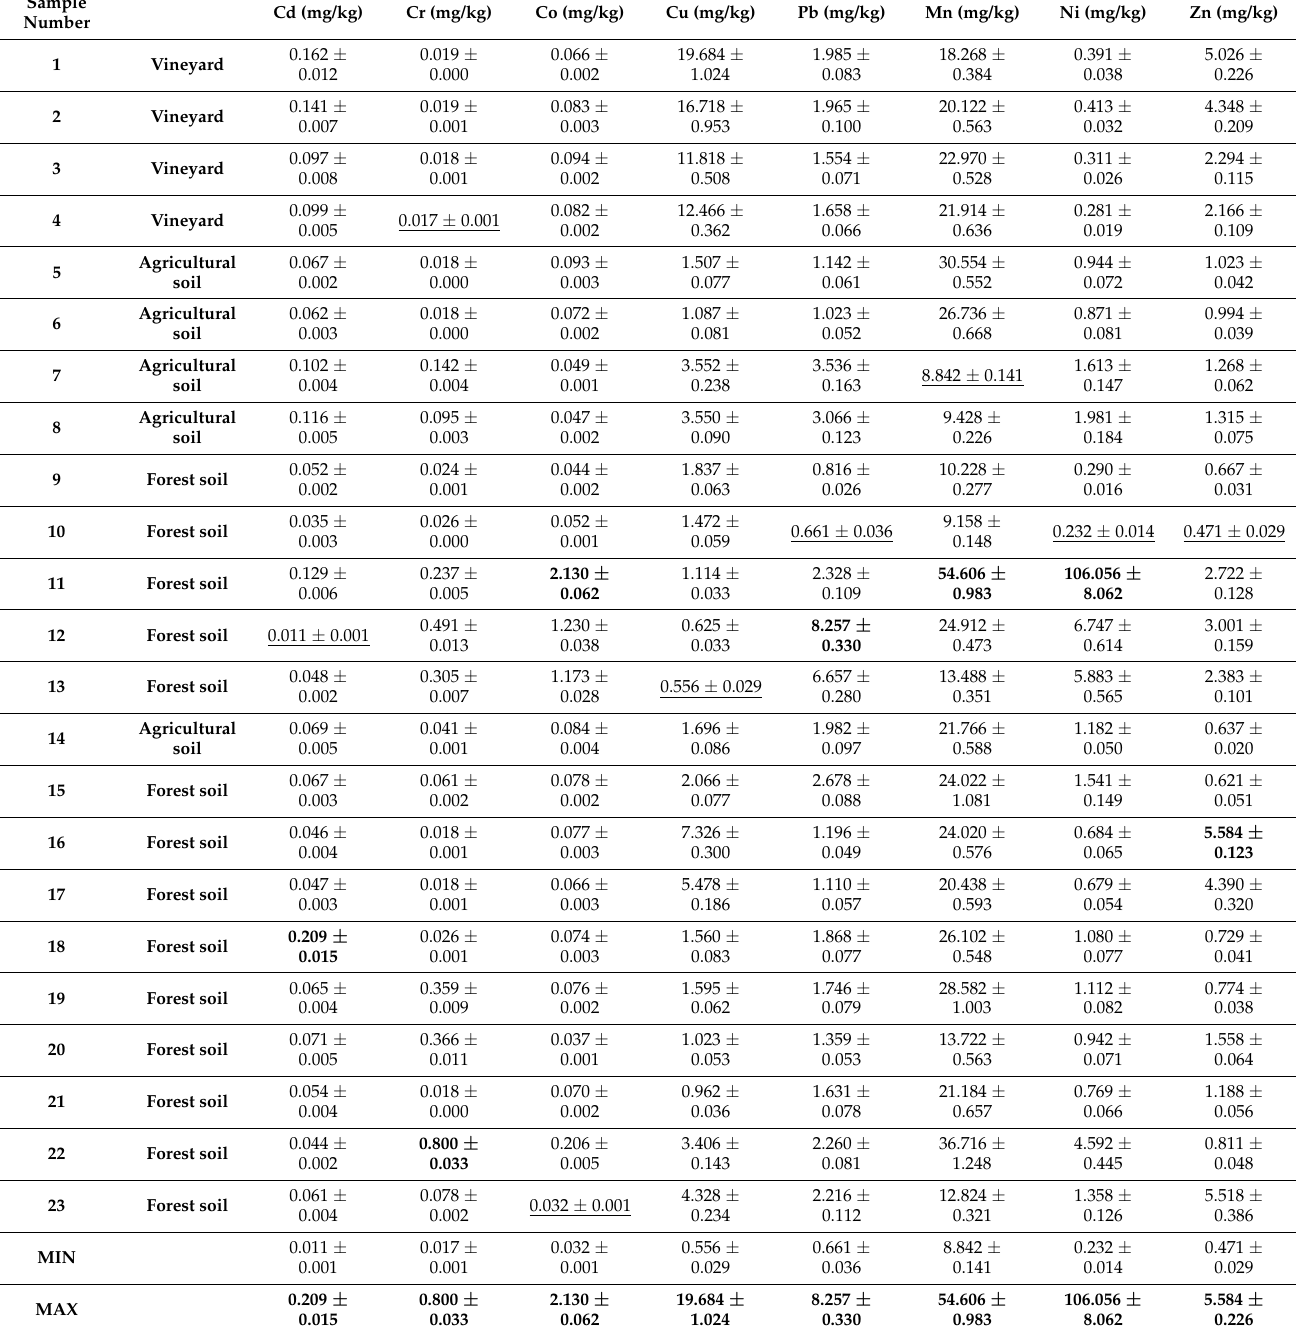
Table 1. DTPA-extractable metal content in soil samples from different locations as described in the footer of the table (maximum concentrations are underlined and minimum in bold font). Results are presented as concentration in mg/kg ±